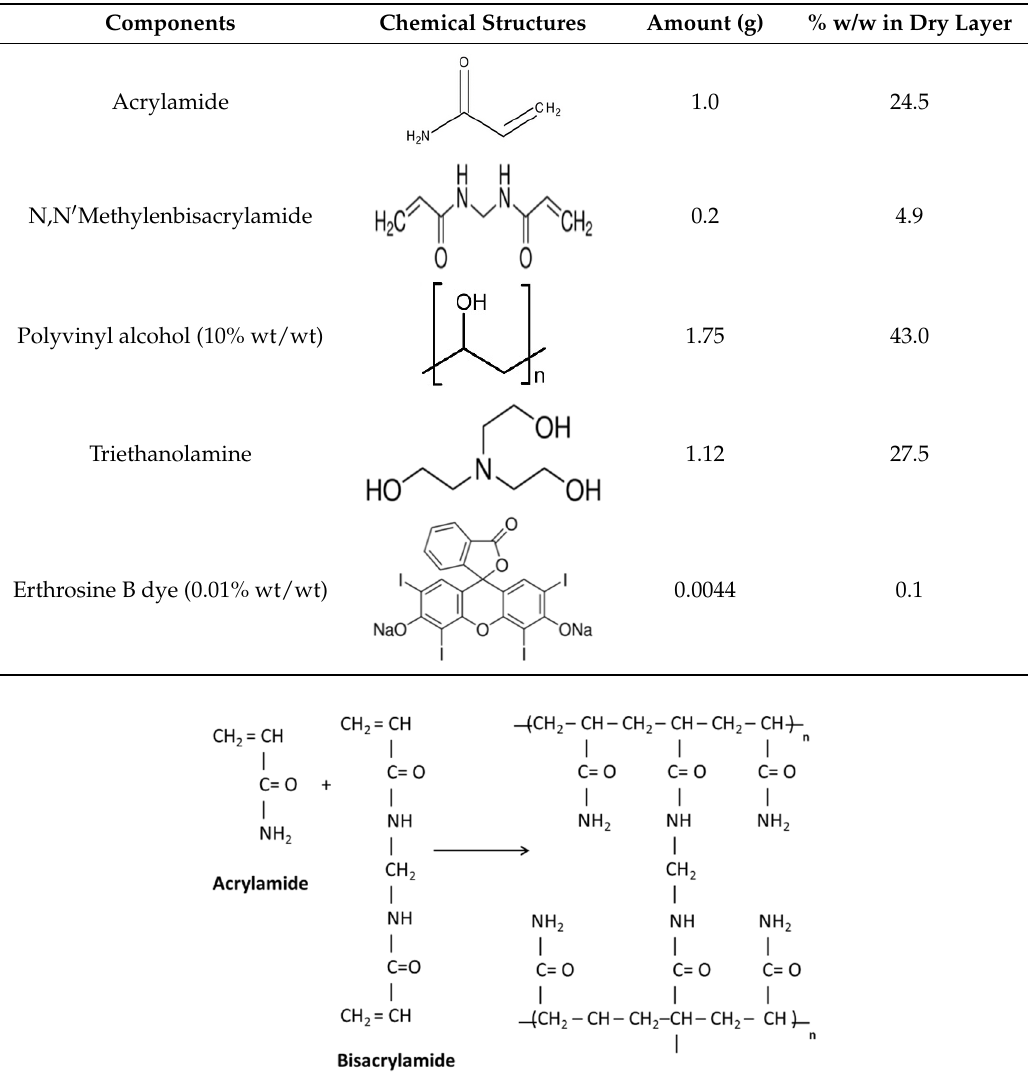
Table 1. Composition of the photopolymer.